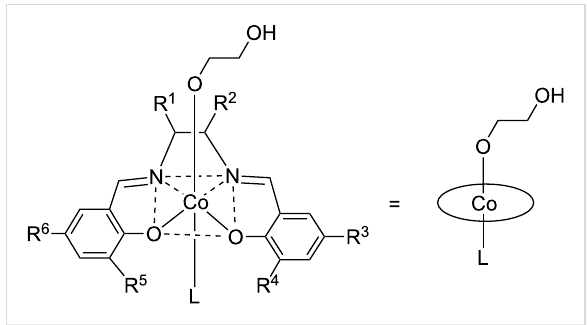
Figure 2: The [(2-hydroxyethoxy)Co III (salen)(L)] complex chosen as catalyst model for the calculations; 1 : R 1–6 = H; 1a : = -C 4 H 8 -, R 3–6 = H; 1b : = -C 4 H 8 -, R 3–6 = t